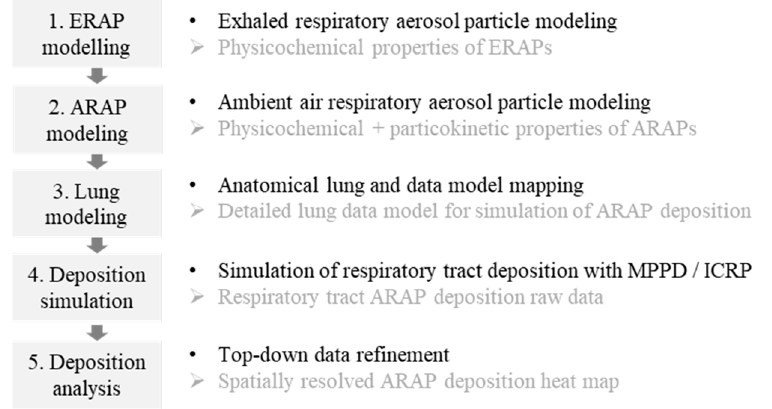
Figure 2. Overview of the five modeling and analysis steps. Bullet points: • activity; outcome. ERAP, exhaled respiratory aerosol particle; ARAP, ambient air respiratory aerosol particle; MPPD, Multiple Path Particle Dosimetry model; ICRP, International Commission on Radiological Protec- tion model.